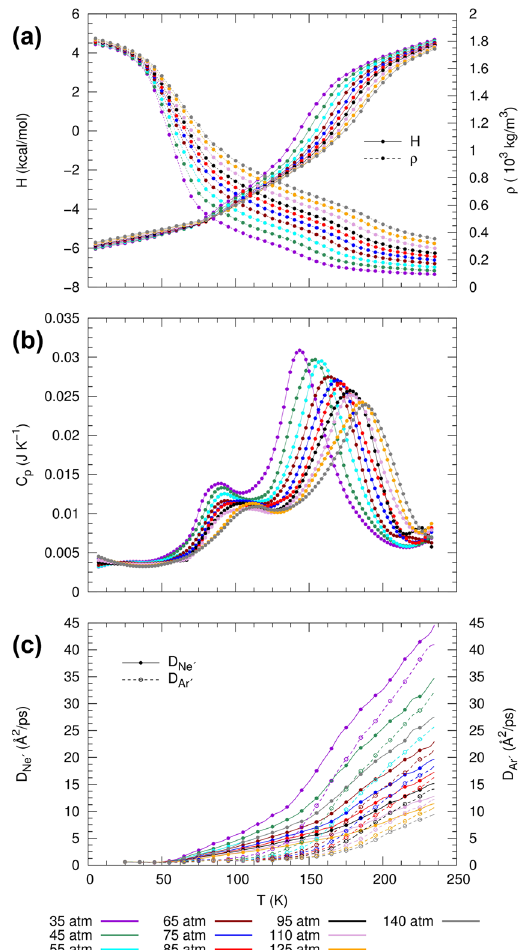
Figure 5. Thermophysical properties and response functions for equimolar Ne ′ /Ar ′ mixture with strong self- interaction, showing ( a ) supercritical isobars of enthalpy H and density ρ , ( b ) isobaric heat capacity C p as a function of temperature, and ( c ) diffusion coefficients ( D Ne ′ and D Kr ′ ) as obtained along the simulated